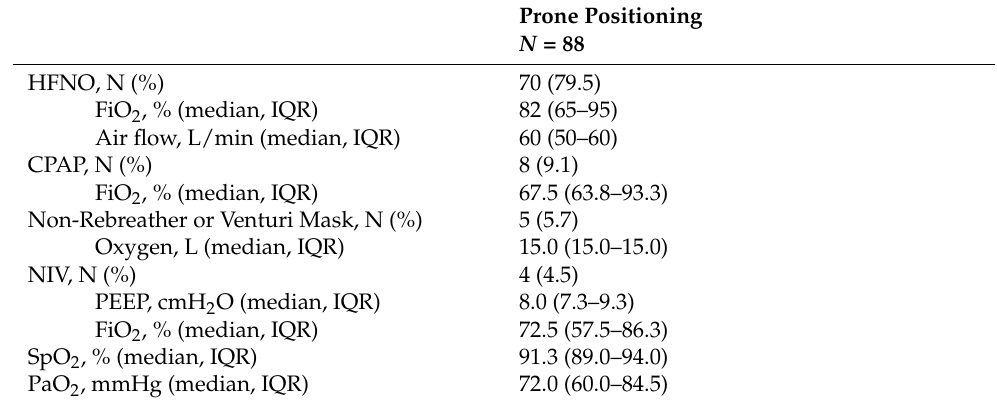
Table 2. Oxygen supplementation at start of prone